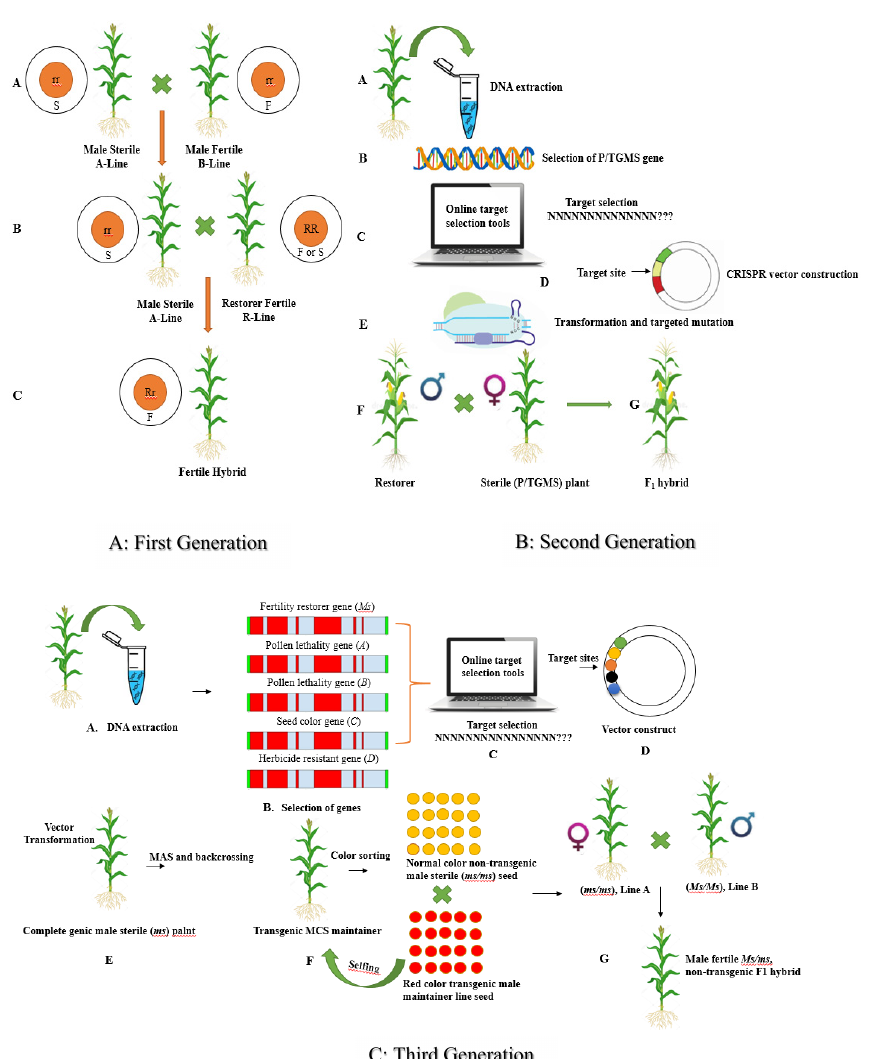
Figure 3. Schematic description all three generations of hybrid development. ( A ) First generation or three-line hybrid development system consisting of A (male sterile), B (male fertile), and R (restorer) lines; ( B ) second-generation or two-line hybrid development system through targeted mutagenesis of the P/TGMS gene, later crossed with restorer line; ( C ) third generation or MCS system through multiplexing of genes controlling MS, pollen lethality and color sorting. The mutants are backcrossed with selfing of the MCS maintainer line to develop desirable